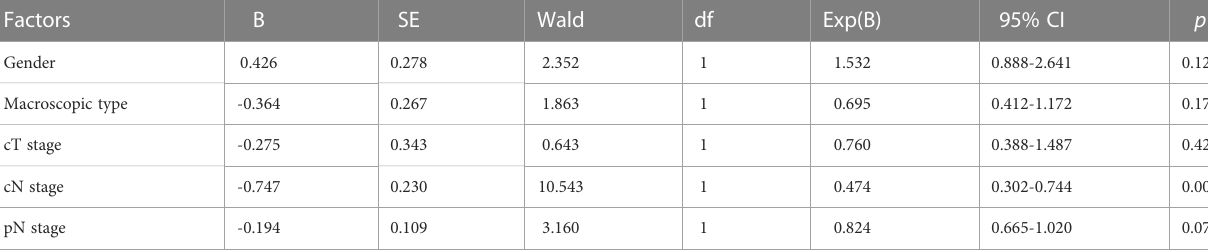
TABLE 2 Preoperative risk factors of sPAN by logistic regression